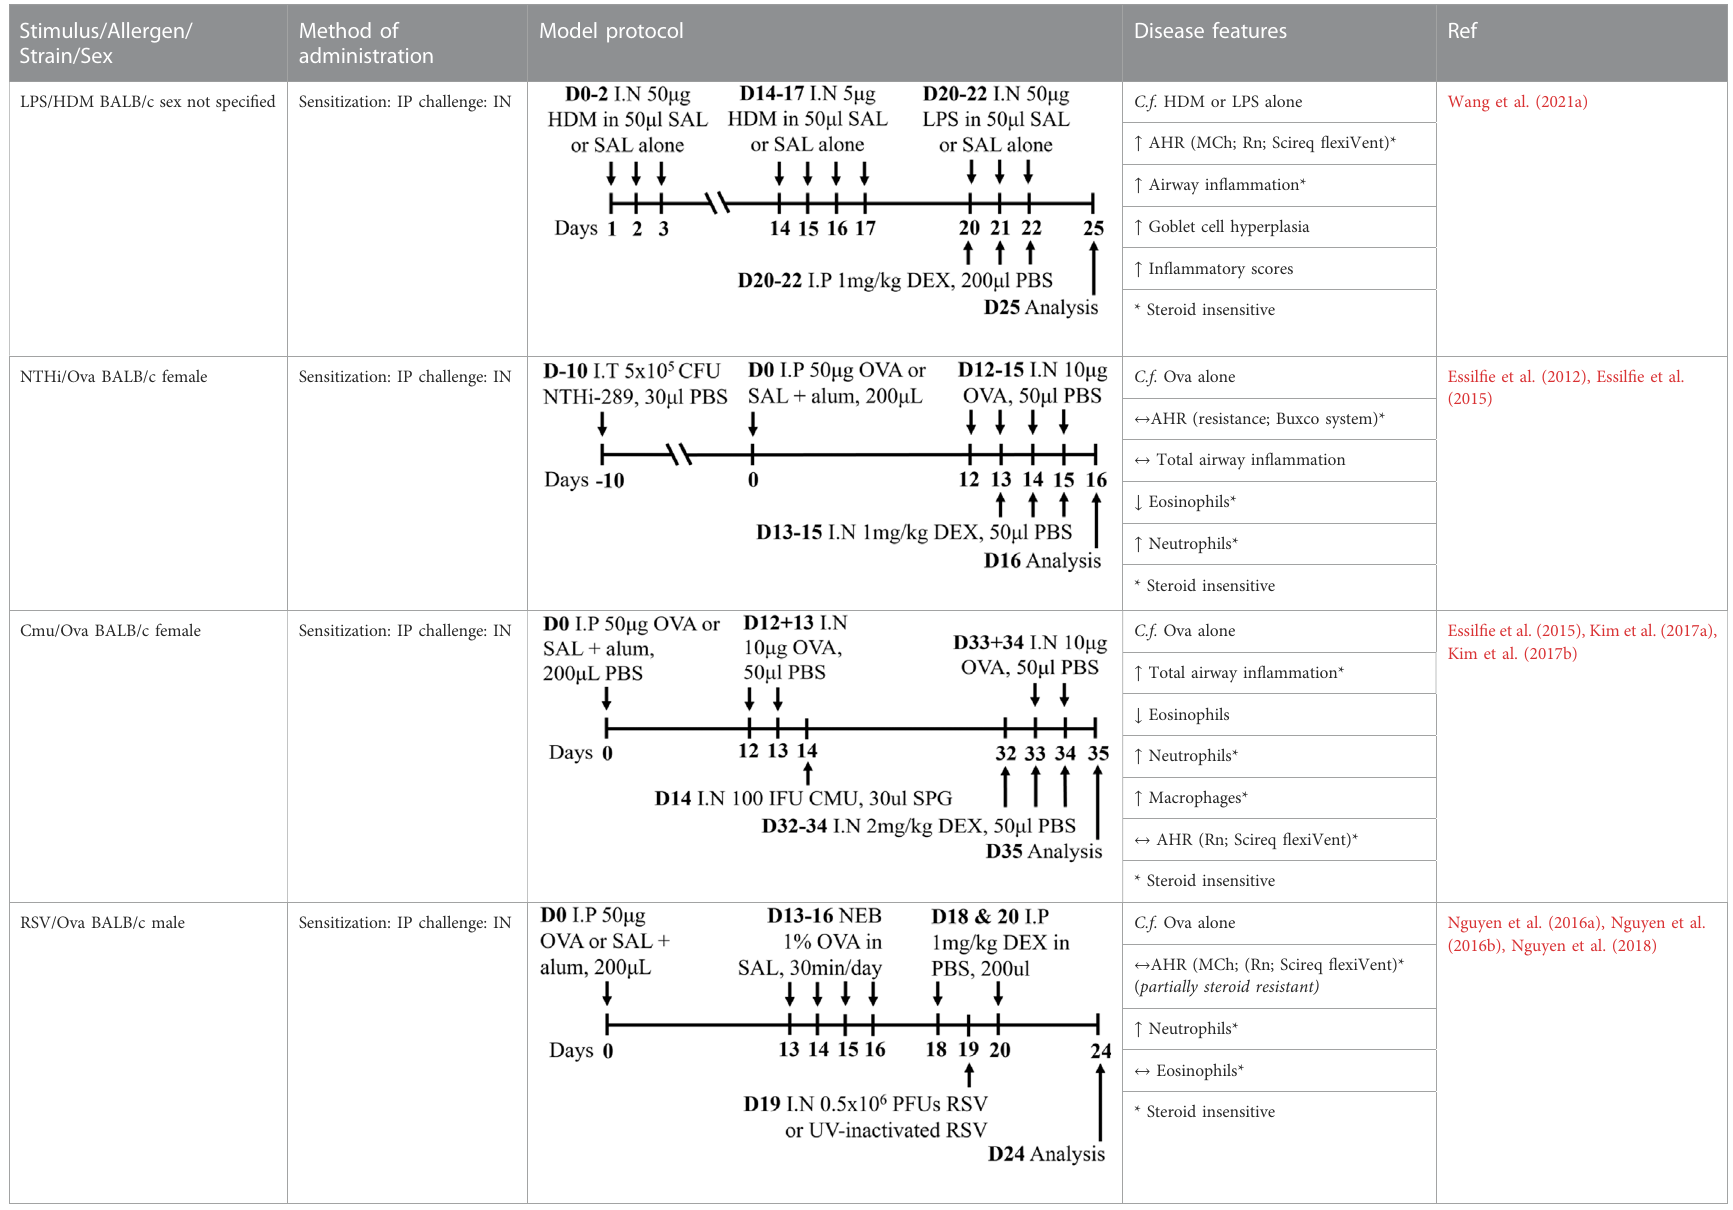
TABLE 2 Experimental mixed-exposure asthma